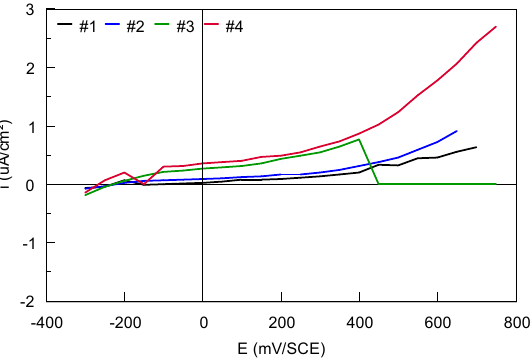
Figure 20. Potentiostatic polarization plots, current value recorded after 15 min, versus the preselected potentials for bulk Ti-based alloys.